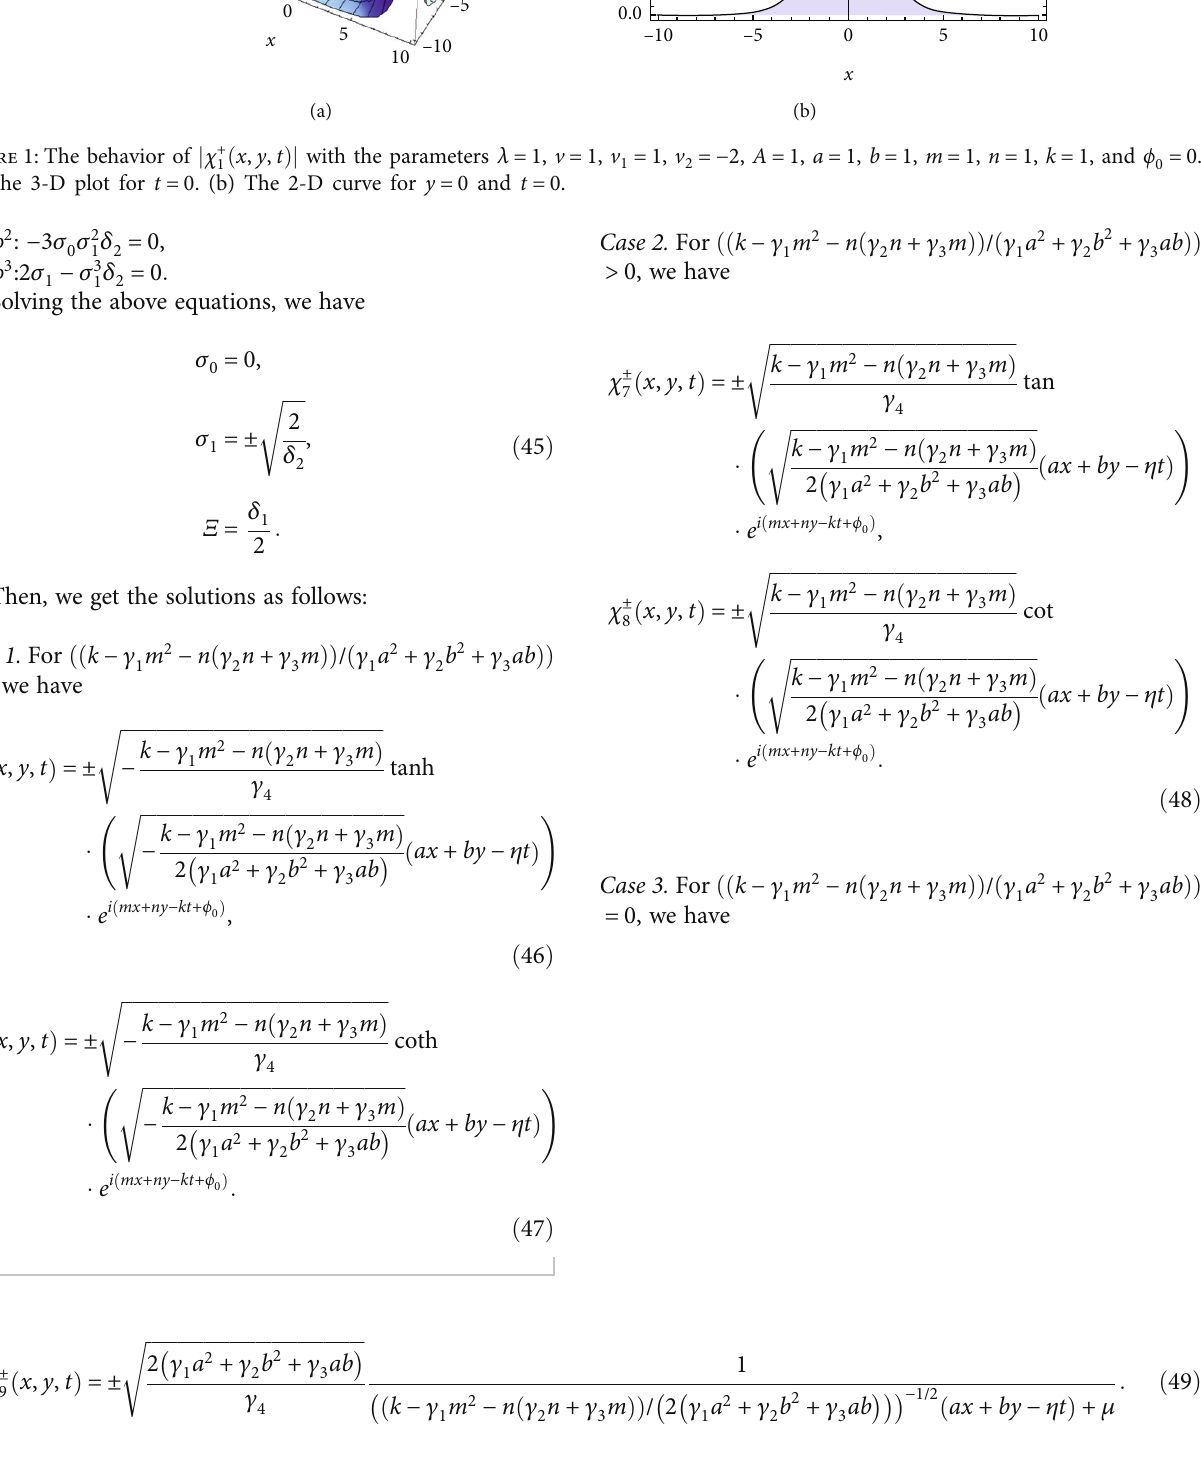
= 1 , v = − 2 , A = 1 , a = 1 , b = 1 , m = 1 , n = 1 , k = 1 , and ϕ 1 2